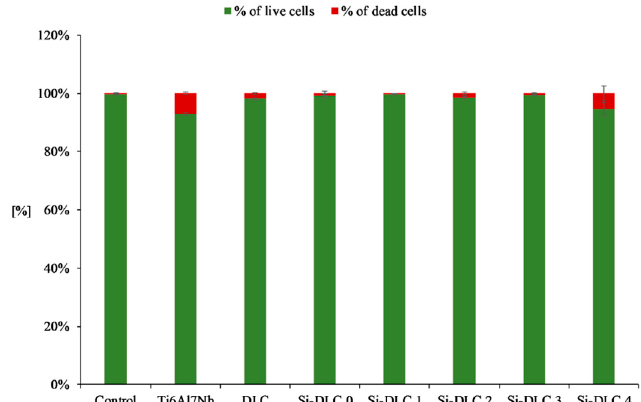
Figure 8. Cytotoxicity of the deposited Si-DLC coatings towards the endothelial cells (live / dead assay).